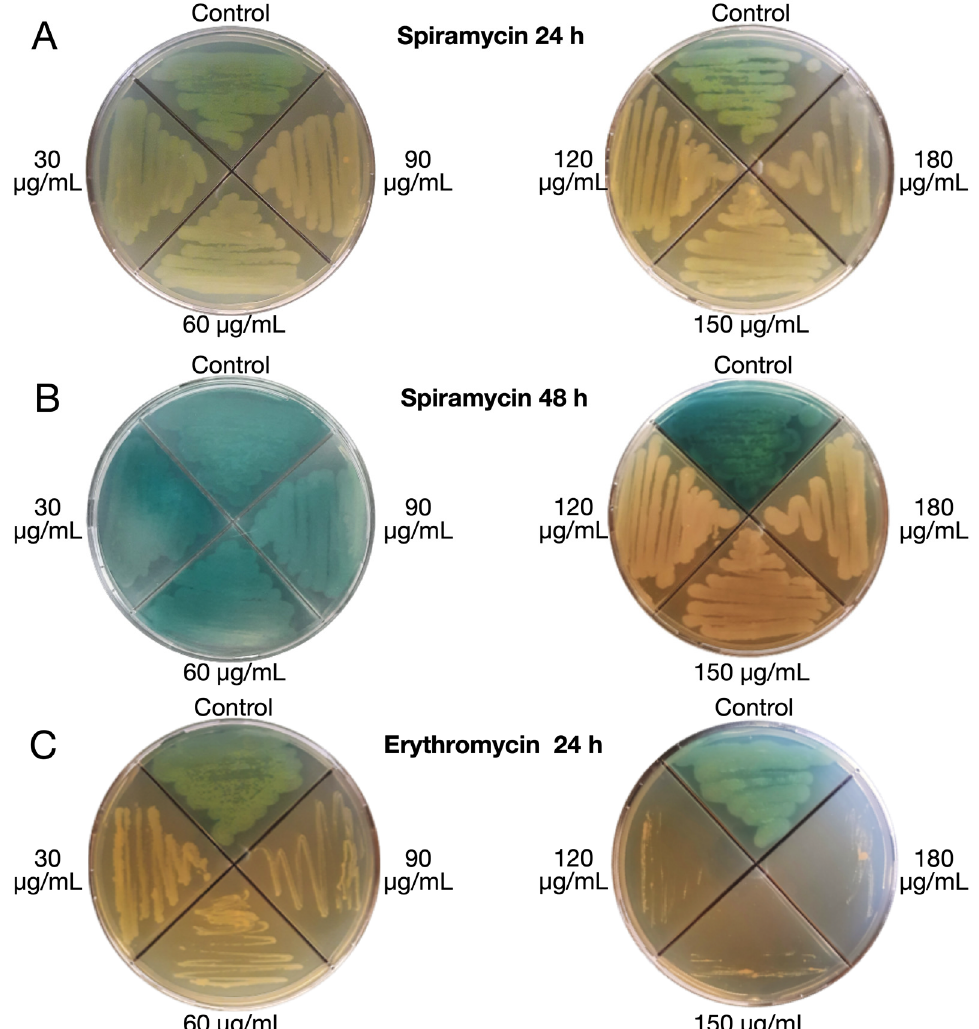
Figure 3. Phenotype of P. aeruginosa GG-7R growing on LB agar in the absence or presence of spiramycin or erythromycin. ( A ) Effects of spiramycin at 24 h of incubation (37 °C). ( B ) Effects of spiramycin at 48 h of incubation (37 °C). ( C ) Effect of erythromycin at 24 h of incubation (37 °C).